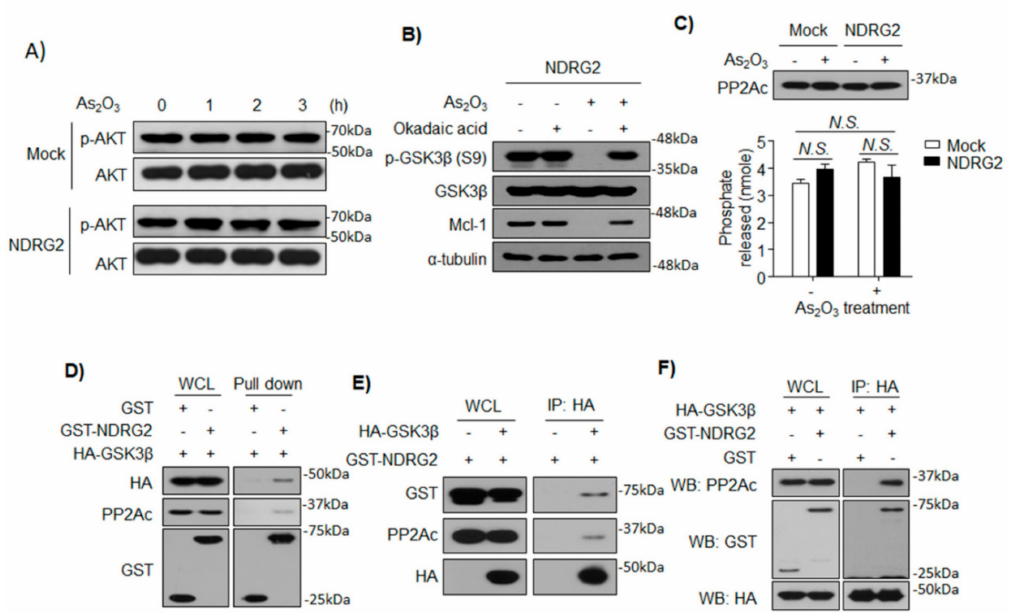
Figure 4. GSK3 β